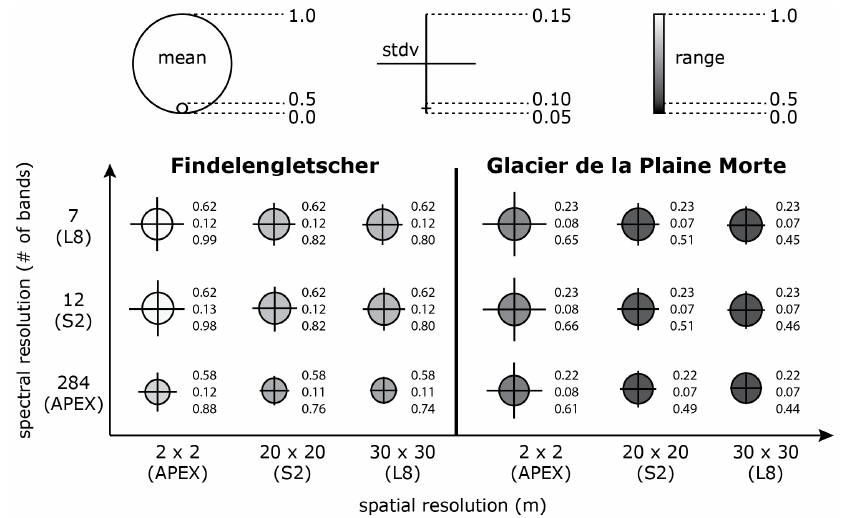
Figure 5. Glacier-wide mean shortwave albedo (circle), standard deviation (cross), and range (gradient) as a function of spatial (x-axis) and spectral (y-axis) resolution for Findelengletscher ( left ) and Glacier de la Plaine Morte ( right ). The three parameters mean ( top ), standard deviation ( middle ) and range ( bottom ) are given in exact numbers per individual product. For Glacier de la Plaine Morte, circles and crosses are enlarged tenfold for better readability.